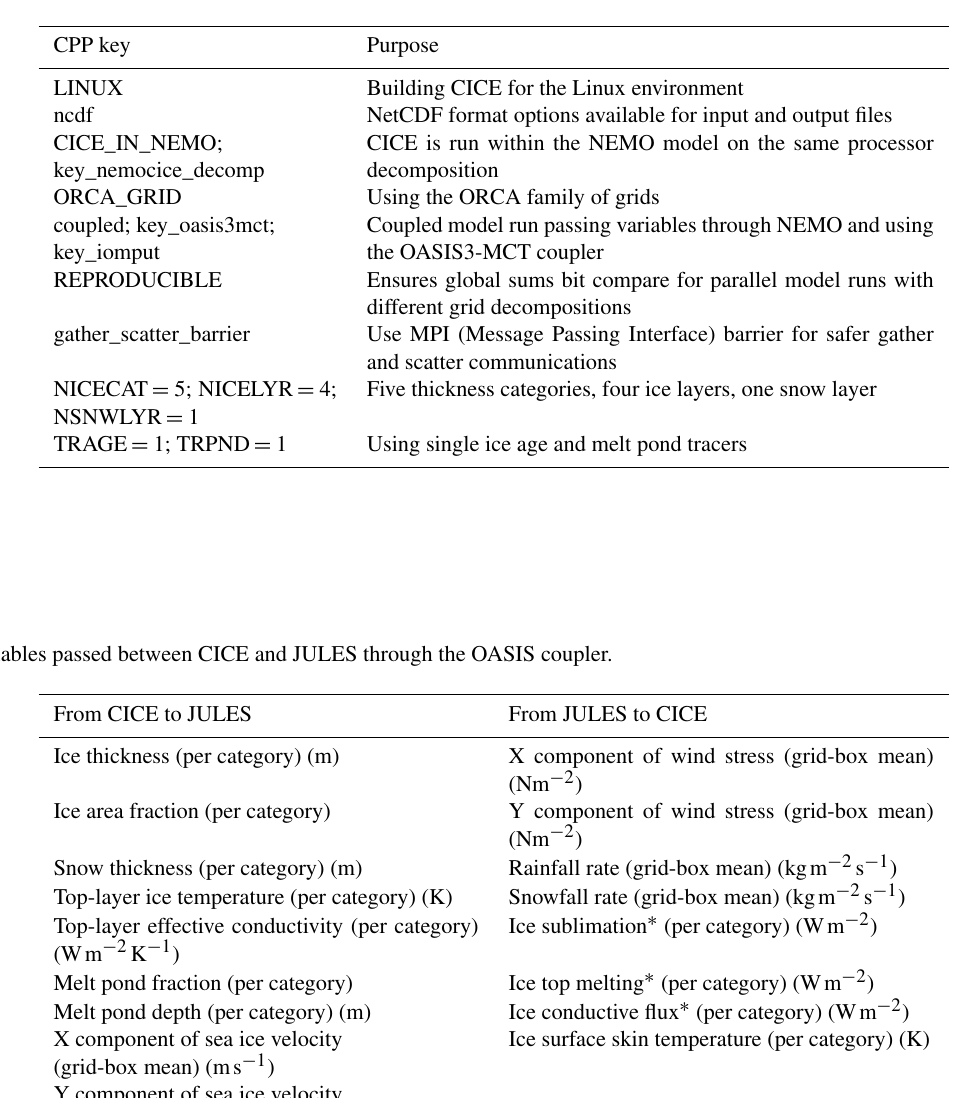
Table B1. C pre-processor (CPP) keys used to build the GSI8.1 CICE component of HadGEM3-GC3.1.